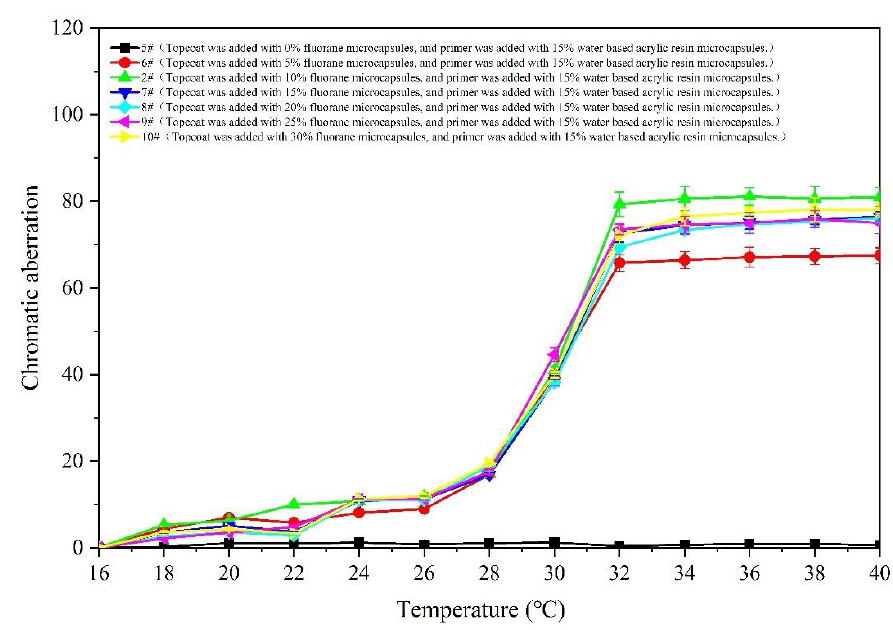
Figure 7. The influence of temperature rise on color difference of coating.